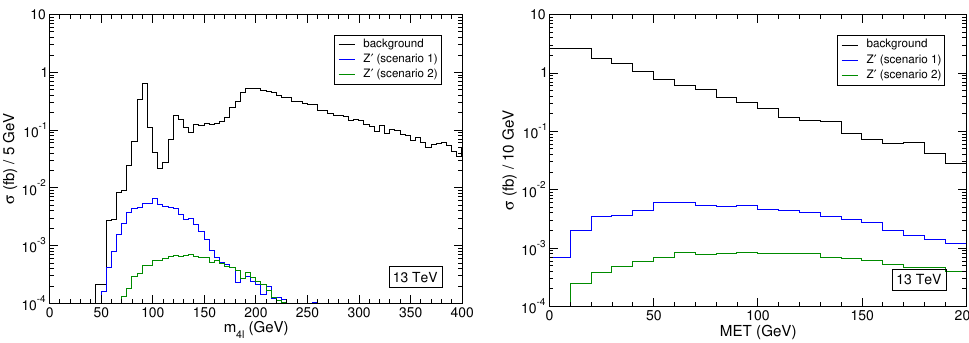
Figure 4 . Four-lepton invariant mass (left) and missing energy (right) for the signal and the SM background, for a CM energy of 13 TeV and the two benchmark scenarios de(cid:12)ned in eqs. (5.1),